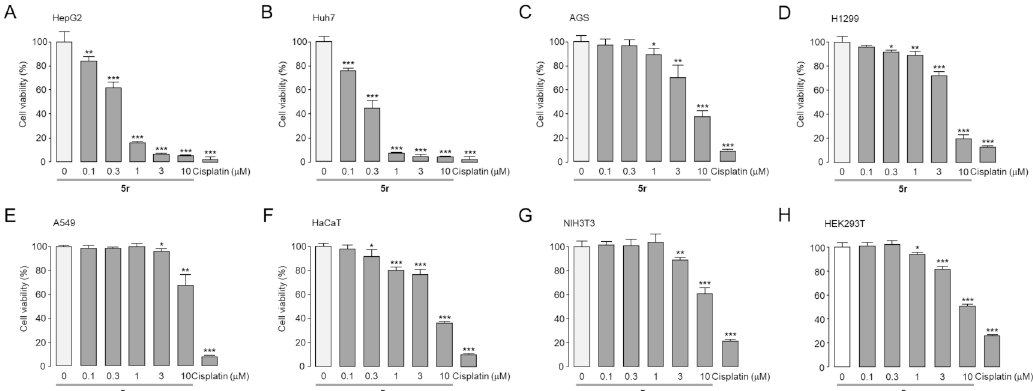
Figure 2. Effect of 5r on cell viability in HepG2, Huh7, AGS, H1299, A549, HaCaT, NIH3T3, and HEK293T cells. ( A – H ) HepG2, Huh7, AGS, H1299, A549, HaCaT, NIH3T3, and HEK293T cells were cultured with 5r at the indicated concentrations for 72 h, and medium was replaced every 24 h with freshly added 5r . Cell viability was measured by MTS analysis (mean ± S.D., n = 5). * p < 0.05, ** p < 0.01, *** p < 0.001.